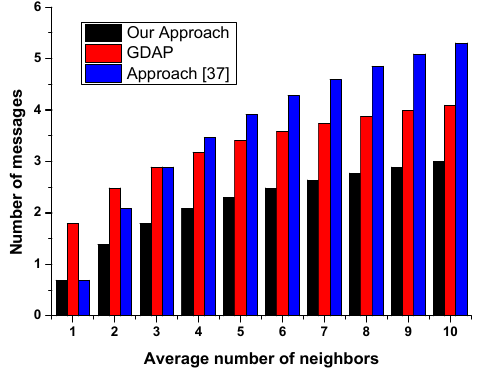
Figure 6. Comparison between the three approaches based on exchanged